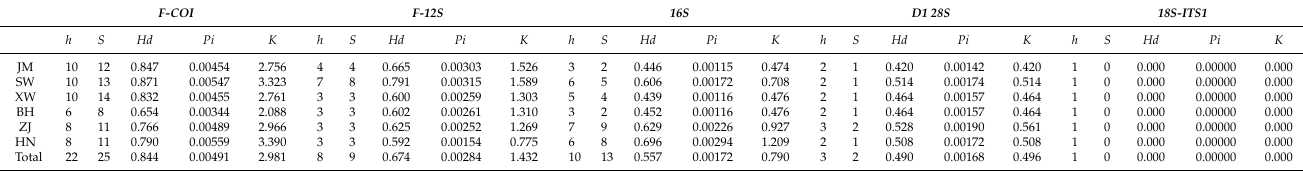
Table 3. Genetic diversity parameters for six populations of Mytella strigata in China based on five different molecular markers. JM, Jimei; SW, Shanwei; XW, Xuwen; BH, Beihai; ZJ, Zhanjiang; HN, Hainan; h , number of haplotypes; S , number of polymorphic (segregating) sites; Hd , haplotype (gene) diversity; Pi , nucleotide diversity; K , average number of nucleotide differences.